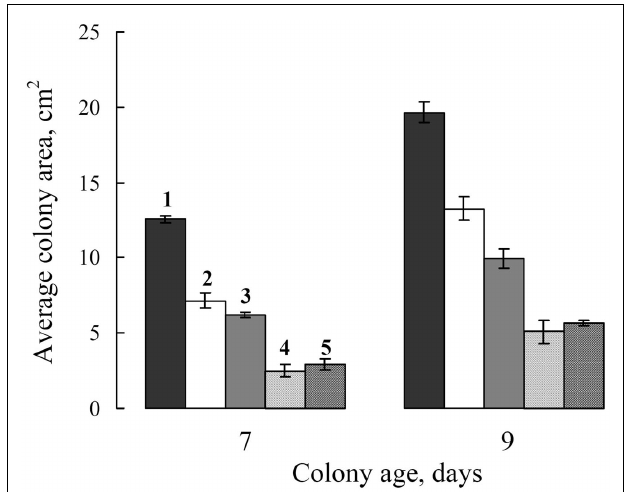
FIGURE 10 | Colony size of S. nodorum after 7 and 9days of culture on: (1) PDA, alone (control); (2) PDA supplemented with FS-94 cultural liquid filtrate (FCL) to final concentration 10% by volume, alone; (3) PDA supplemented with Dividend, 0.01ppm, alone; (4) PDA supplemented with Dividend, 0.01ppm + FCL, 10 volume percent, and; (5) PDA supplemented with Dividend, 0.05ppm. Bars represent